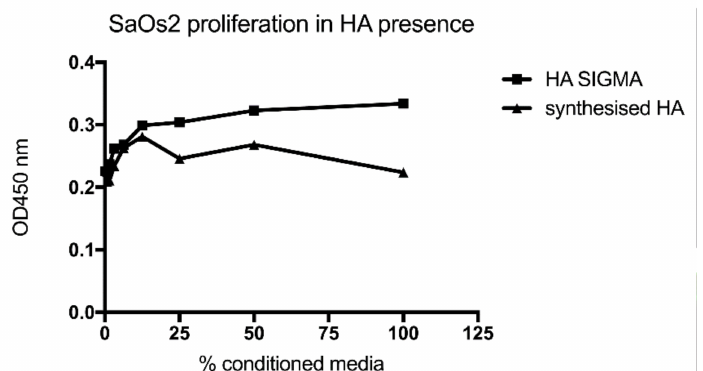
Figure 5. Comparative evaluation of human bone cell proliferation in the presence of synthesized HA and commercial HA. Data are presented as mean values ± SD.